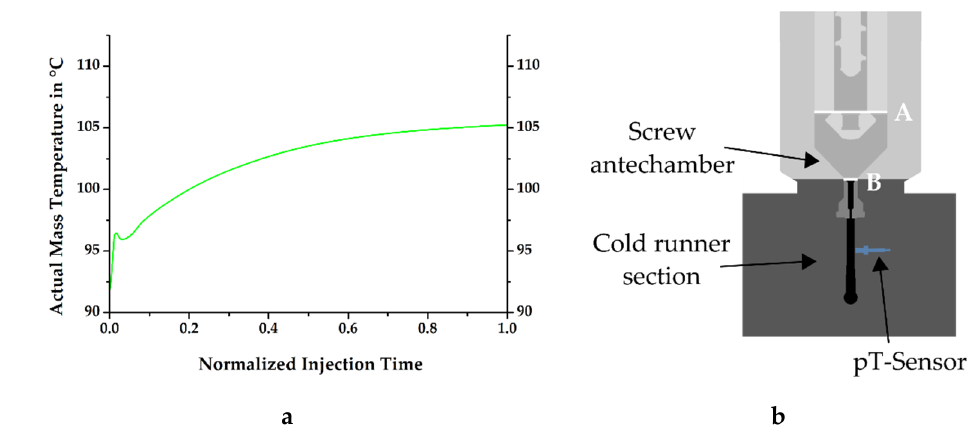
Figure 6. ( a ) Numerically determined mass temperature obtained at plane B after preliminary dos- ing with a screw rotational speed of 90 min − 1 and with an injection speed of 18 cm 3 s −1 ; ( b ) Simplified simulation setup showing the position of the appliance for the calculated mass temperature profile during injection at B.